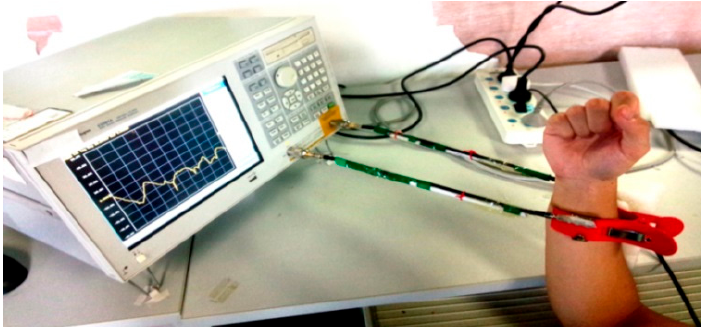
Figure 4. Experimental scenario.